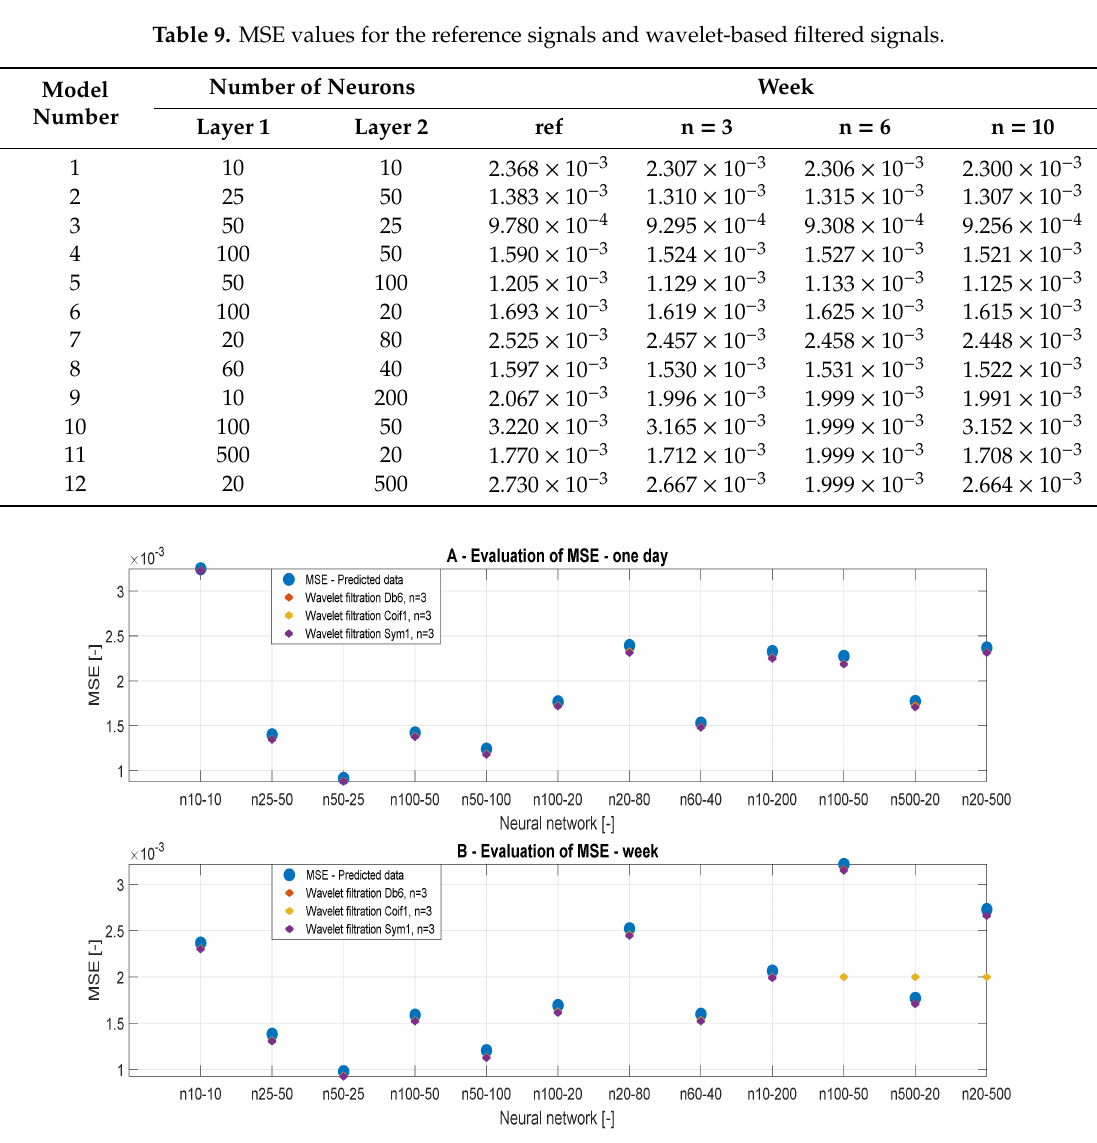
Figure 16. MSE values, a comparison of the reference signals with the wavelet-based